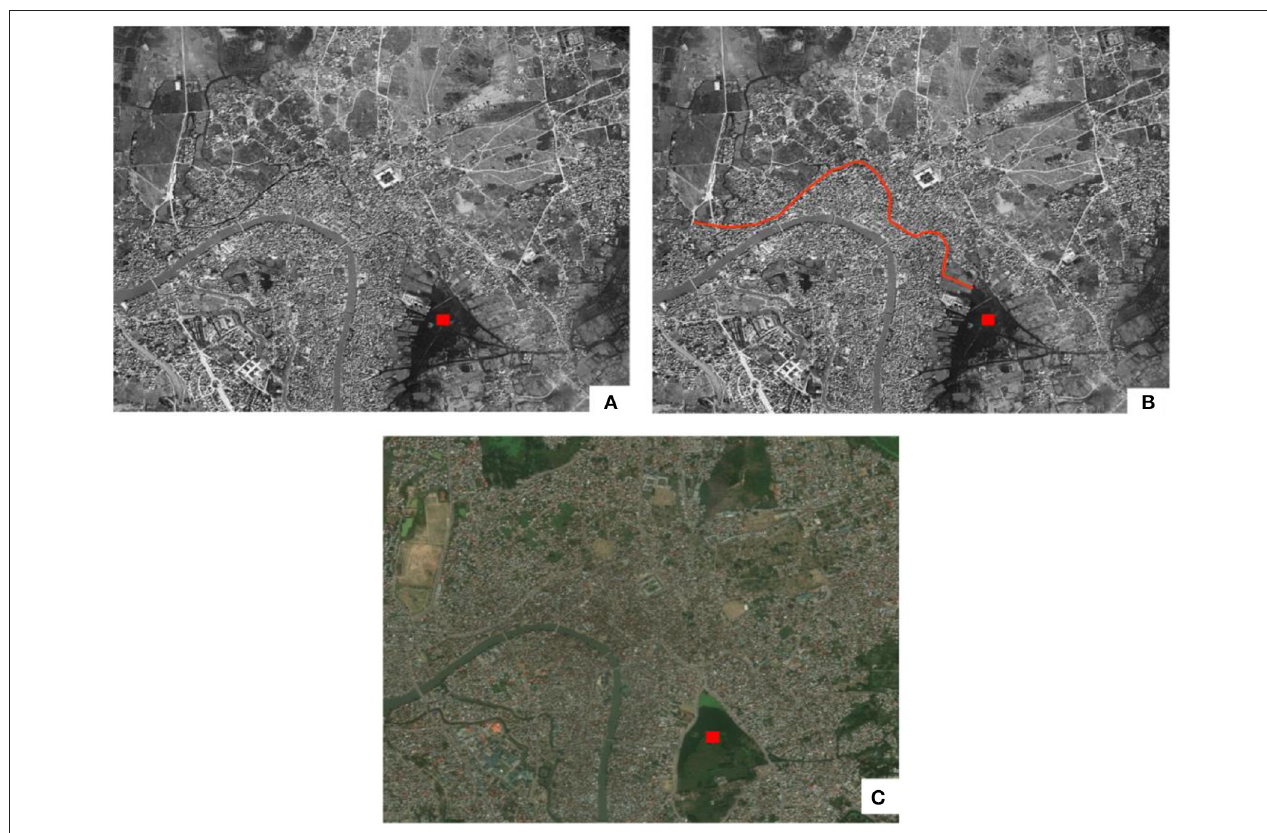
FIGURE 3 | Filling up of Mar Canal as seen from earth observation data (A,B) Declassified CORONA spy images showing Mar canal in 1965. Red Line in (B) indicates Mar canal. (C) Road built by filling up the Mar Canal. Red dot indicates Brari